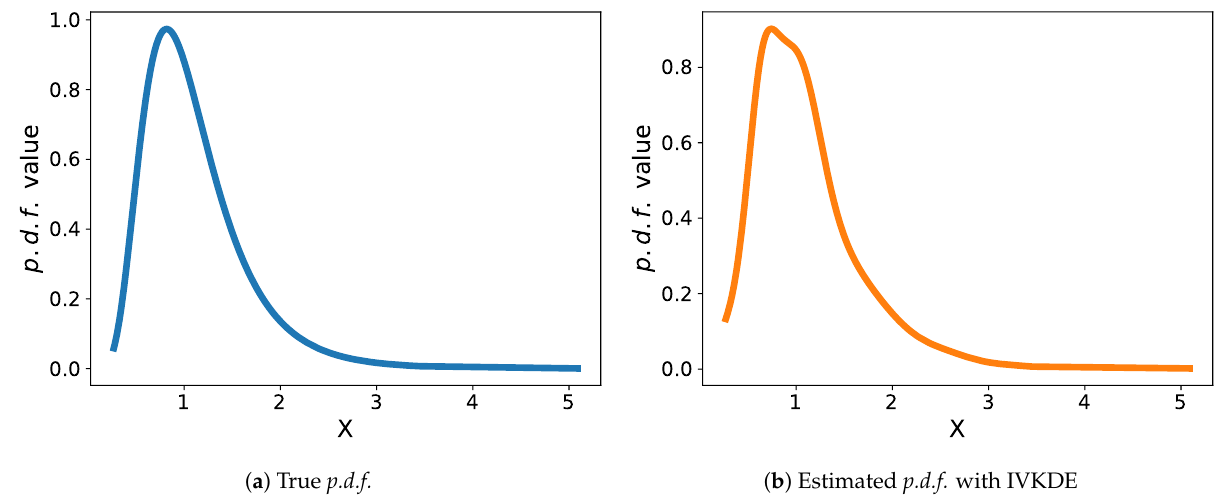
Figure 3. Estimation capability of IVKDE on F